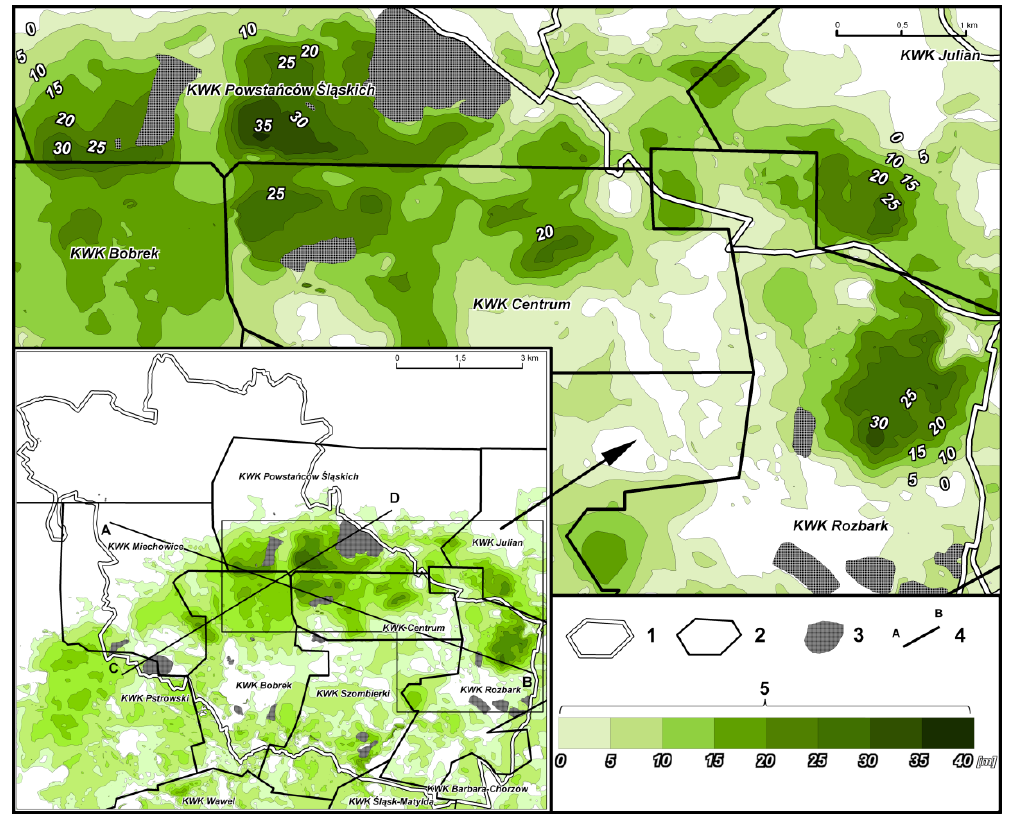
Fig. 2. Values of the area subsidence in Bytom at the end of the 20 th century (1994)(the author’s own work) 1 – boundaries of the city, 2 – boundaries of coal mines, 3 – mining waste heaps, 4 – morphological profiles, 5 – values of subsidence